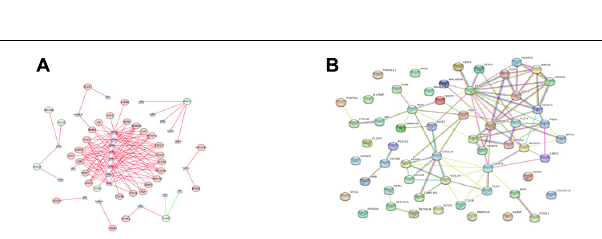
FIGURE 3 | The main regulatory network constructed based on prognosis-related IRGs and CRTFs. (A) The main regulatory network was constructed using Cytoscape for visualization. The circulars represent differentially expressed prognostic immune-related genes, and the purple triangles represent prognosis-related cancer-related transcription factors, respectively. The red circulars represent high-risk genes, and the green circulars represent low-risk genes. Red lines represent positive correlations and green lines represent negative correlations. (B) The PPI network was predicted using the Search Tool for the Retrieval of Interacting Genes online database. Analyzing the functional interactions between proteins may provide insights into the mechanisms of generation or development of